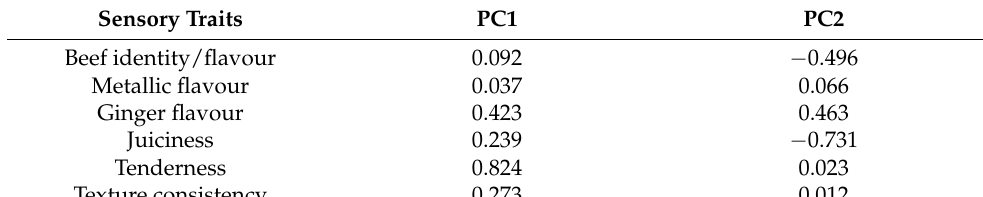
Table 3. Loadings for the first two principal components for the sensory traits.